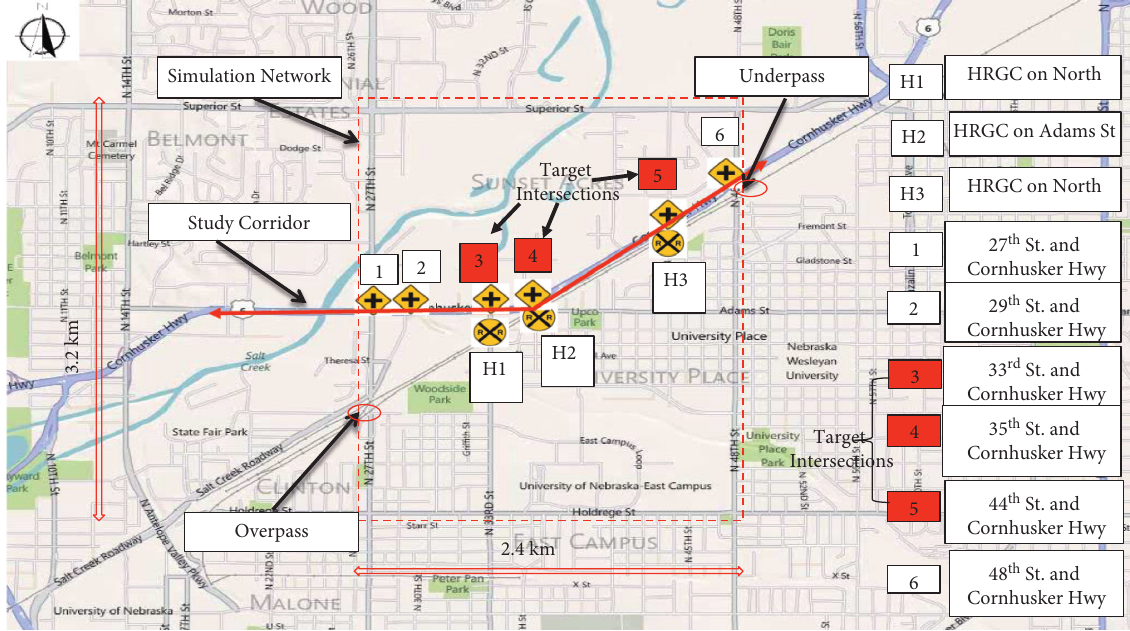
Figure 5: Map of the simulation network and study corridor.